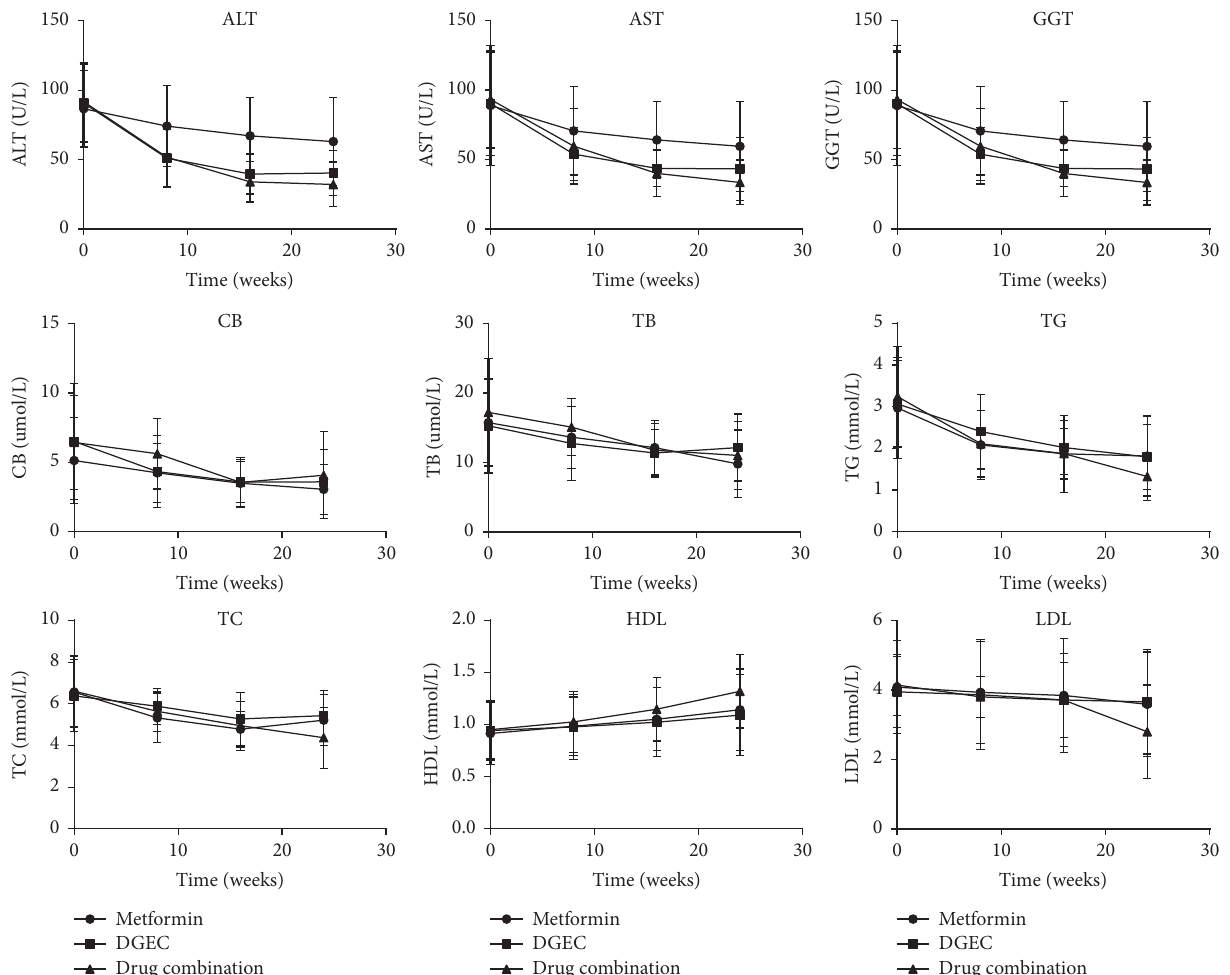
Figure 1: Changes in liver enzymes and lipid parameters over the 24-week treatment period (line